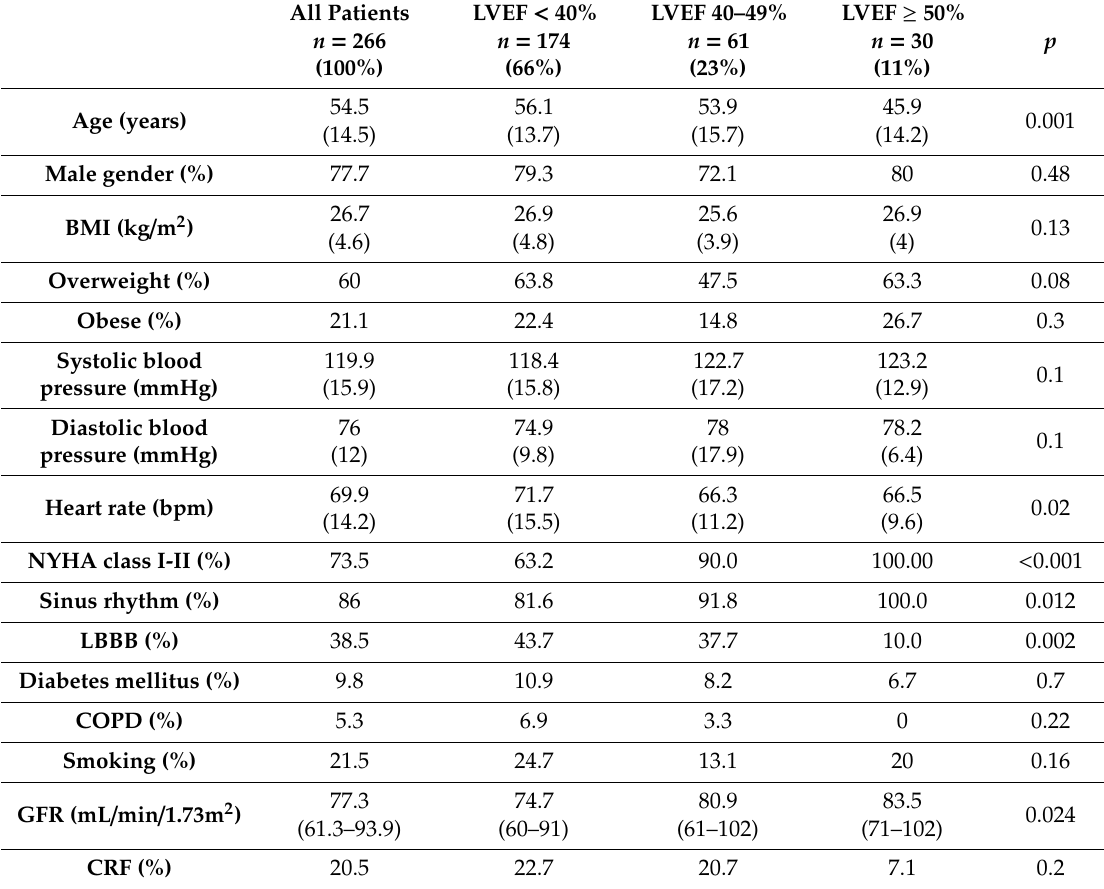
Table 4. Main characteristics of patients stratified by